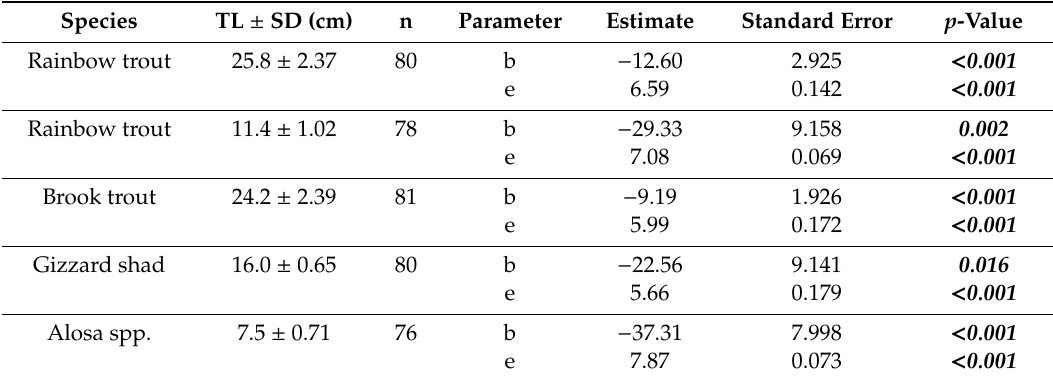
Table 1. Results of log-logistic regression of mortality against blade strike impact velocity for each species, size class within a species, or combination of